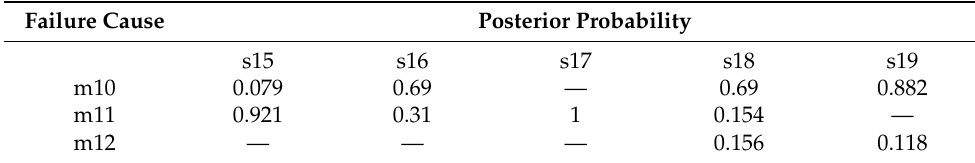
Table 4. The posterior probability in the simple fault